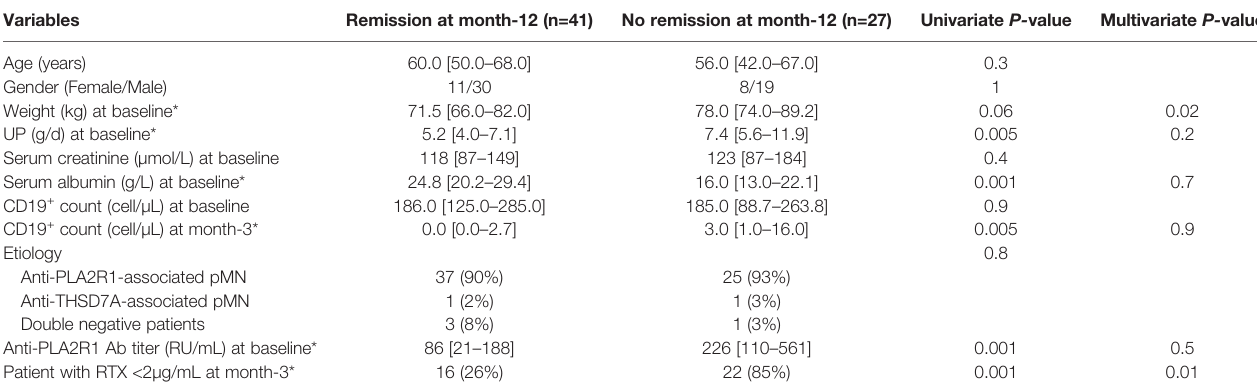
TABLE 3 | Univariate and multivariate analysis of variables associated with clinical remission at month-12. Variables